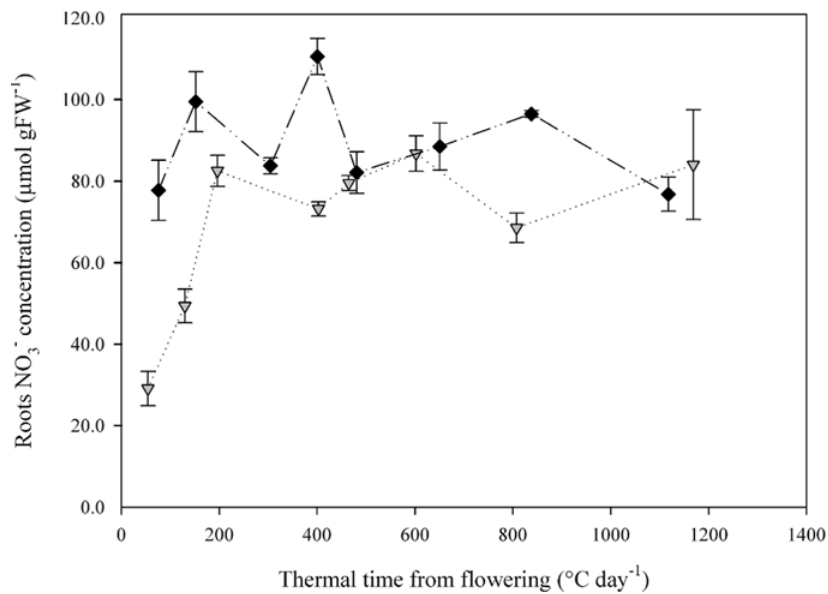
Fig 3. Roots NO 3- concentration dynamics during the post-flowering period for two contrasting NO 3- treatments (N4 and N10). Values are the means of four biological repetitions ± 1 standard error for N4 (grey triangles) and N10 (black diamonds).